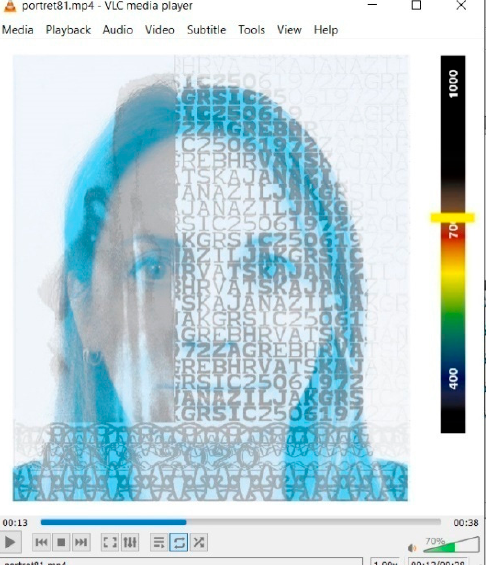
Figure 17. Blockage at 700 nm.